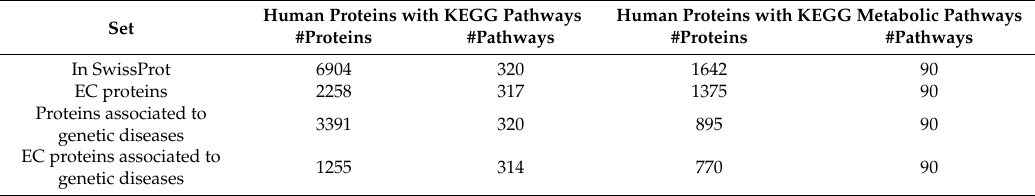
Table 2. EC human protein in Kyoto Encyclopaedia of Genes and Genomes (KEGG) pathways. Human Proteins with KEGG Pathways Human Proteins with KEGG Metabolic Pathways Set #Proteins #Pathways #Proteins #Pathways In SwissProt 6904 320 1642 90 EC proteins 2258 317 1375 90 Proteins associated to 3391 320 895 90 genetic diseases EC proteins associated to 1255 314 770 90 genetic diseases # Number